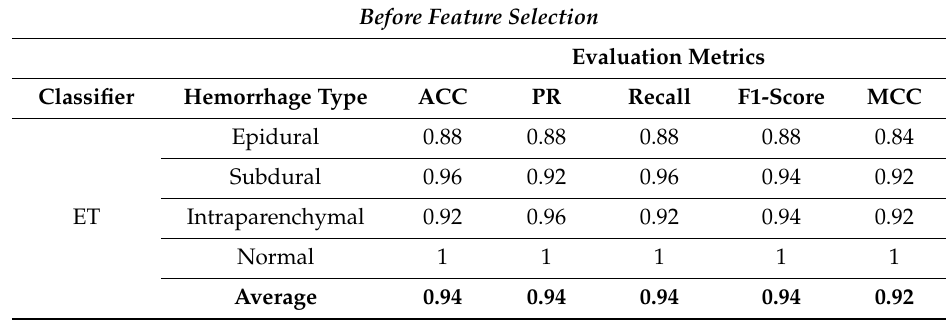
Table A1. Class-wise and average values of performance metrics of individual machine learning methods on CT scan dataset before and after feature